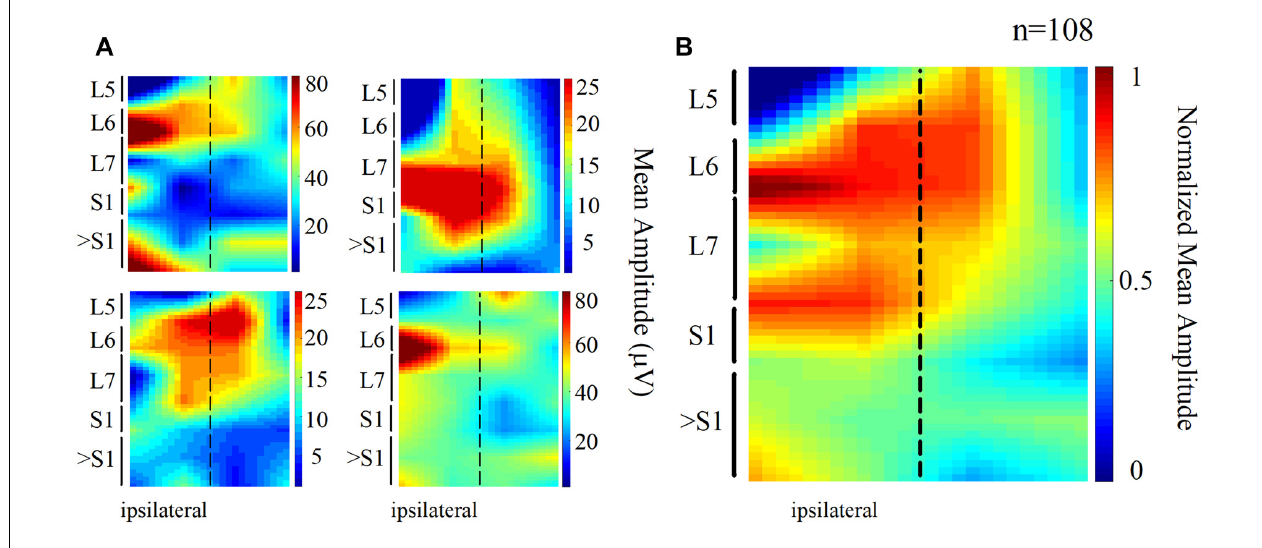
FIGURE 2 | Topographic maps obtained from the spatial distribution of the DC potentials recorded from the cord dorsum. (A) Each map was obtained from one animal. Again, the dashed line represents the midline. Larger amplitudes tend to focus at the ipsilateral (left) L6 and L7 segments. (B) Grand average of the four normalized maps in (A) n = 108 trials, four